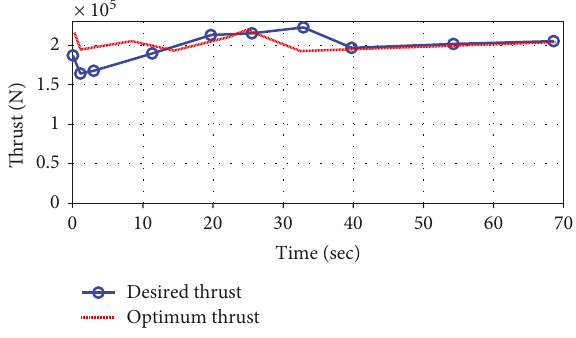
Figure 11: Comparing desired thrust & optimum thrust Table 4: Propellant and nozzle parameters